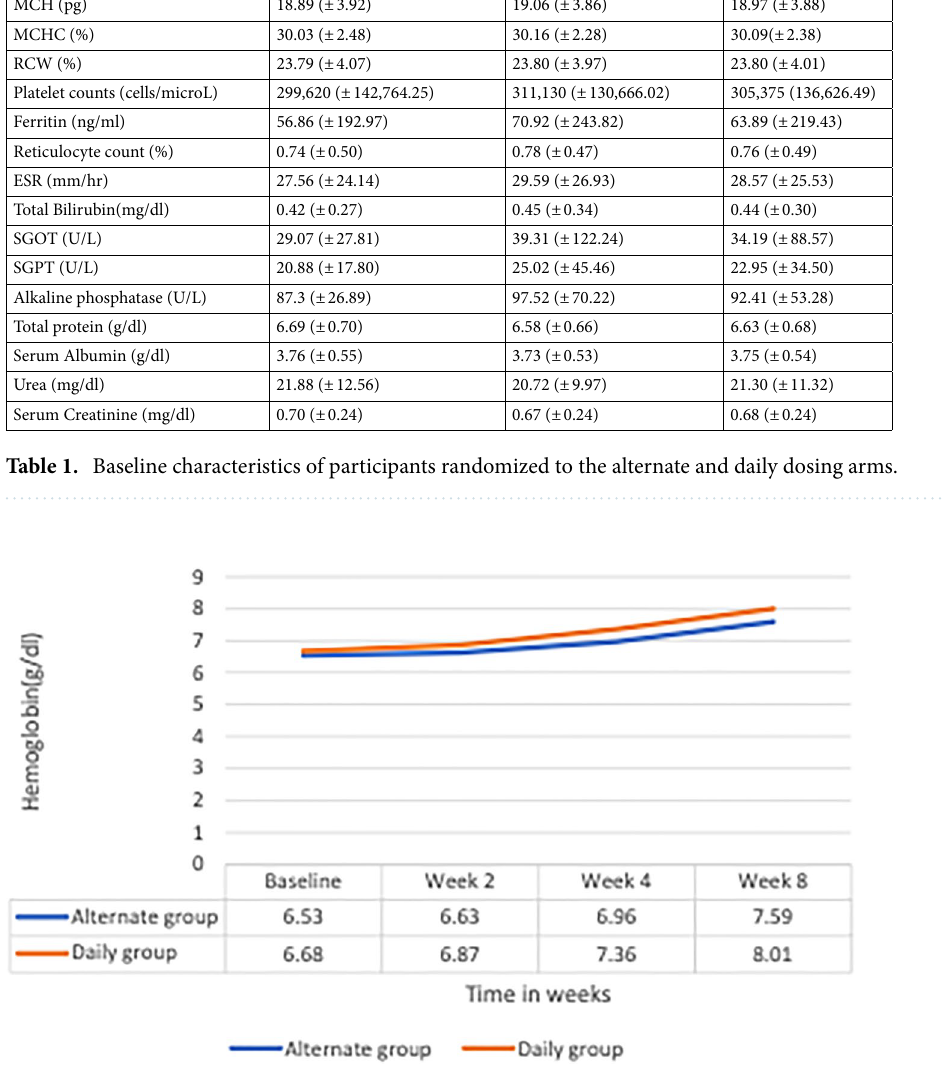
Figure 2. Change in mean hemoglobin levels at weeks 2, 4 and 8 from baseline in patients randomized to daily and alternate day iron therapy.